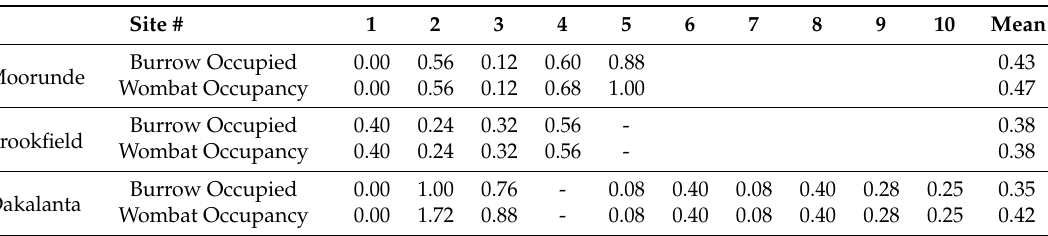
Table 2. Proportion of days during the survey period when the surveyed burrow was occupied by one or more wombats, and the wombat occupancy rate. Four burrows (Moorunde sites #4 and 5 and Dakalanta sites #2 and 3) were occupied by more than one wombat on two, three, twelve and three days respectively.